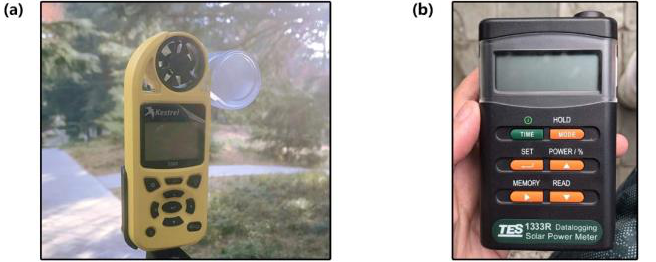
Figure 6. The photo of the Kerel 5500 handheld weather station ( a ) and the TES-1333R solar power meter ( b ). Table 2. Specification of the equipment.